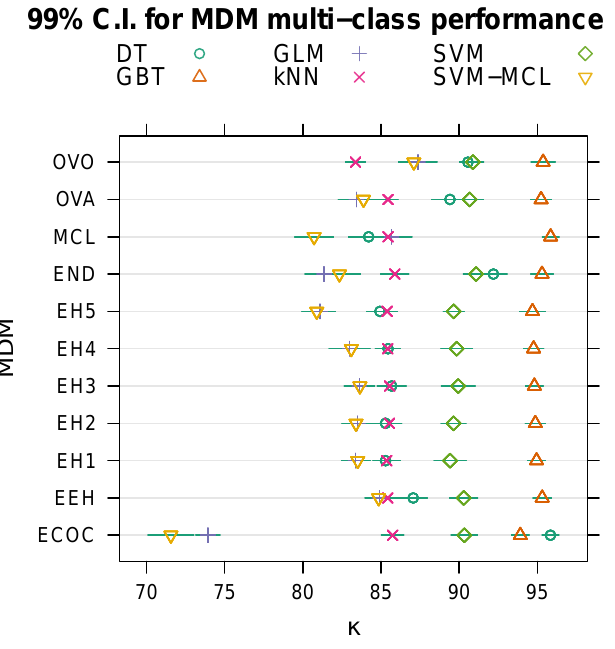
Figure 1. 99% confidence intervals (C.I.) for the effect of the multi-class decomposition method (MDM) on the Kappa statistic for the full 17-class problem.